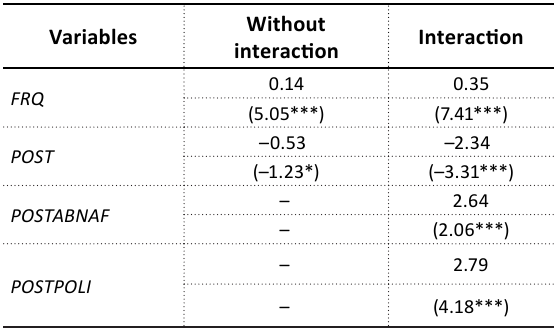
Table 6. Financial reporting quality